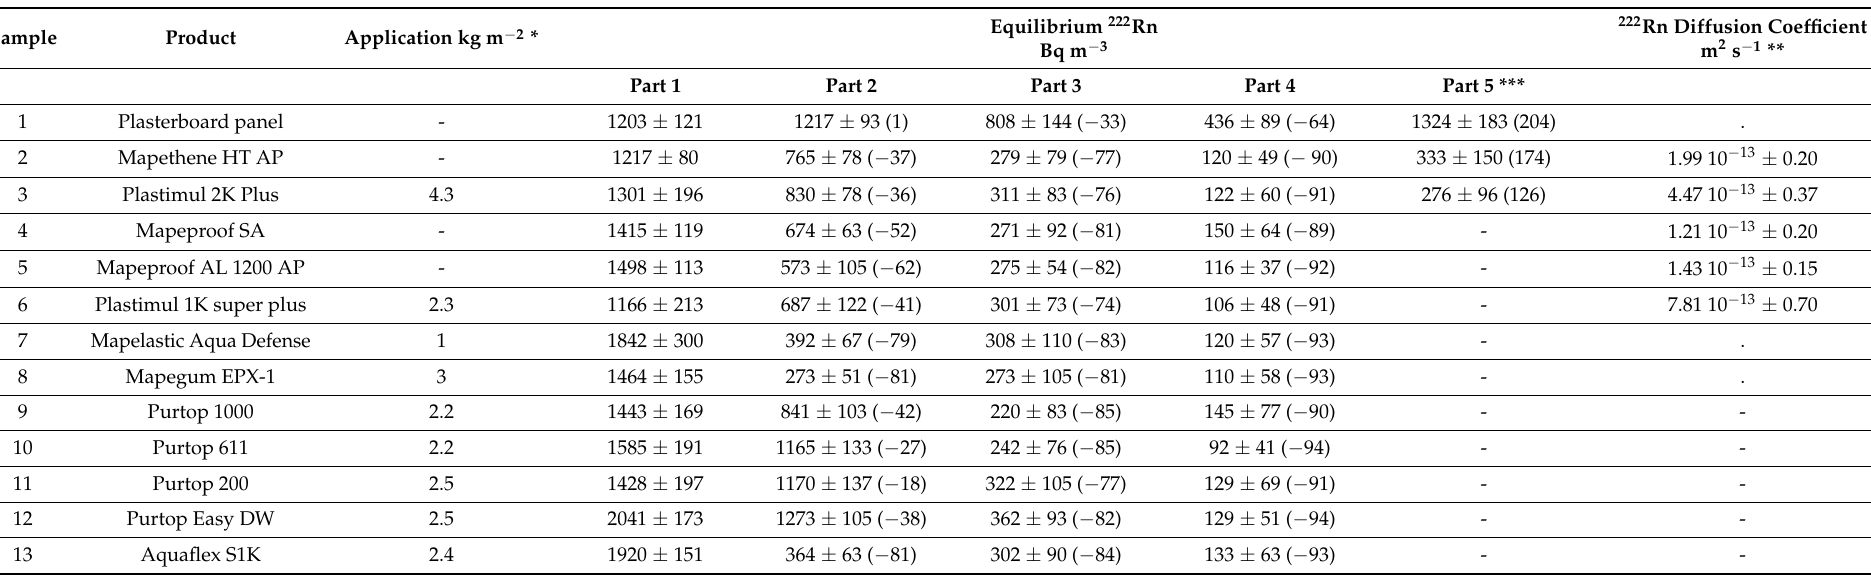
Sample 2 is a bitumen membrane; samples 3 and 6 are bitumen emulsions; samples 4 and 5 are HDPE membranes; samples 7 and 8 are synthetic resins; samples 9, 10 and 11 are polyurea-based membranes; sample 12 is a polyuretanic membrane; sample 13 is a silane terminated polymer. All radon data have been reported to a reference temperature of 23 ◦ C. Errors are quoted as one standard deviation. The numbers in brackets are the relative changes in indoor radon (RIR) detected in the second, third, fourth, or fifth part of each experiment with respect to the reference radon level in the first part. * In the case of liquid membranes, two coats were applied to plasterboard supports. The quantity of product applied per square meter of surface is indicated. ** Data are available on the technical reports of the product at www.mapei.it, accessed on 17 Octorber 2022. *** Radon change in the fifth part of the experiments is calculated with reference to the radon value of the fourth